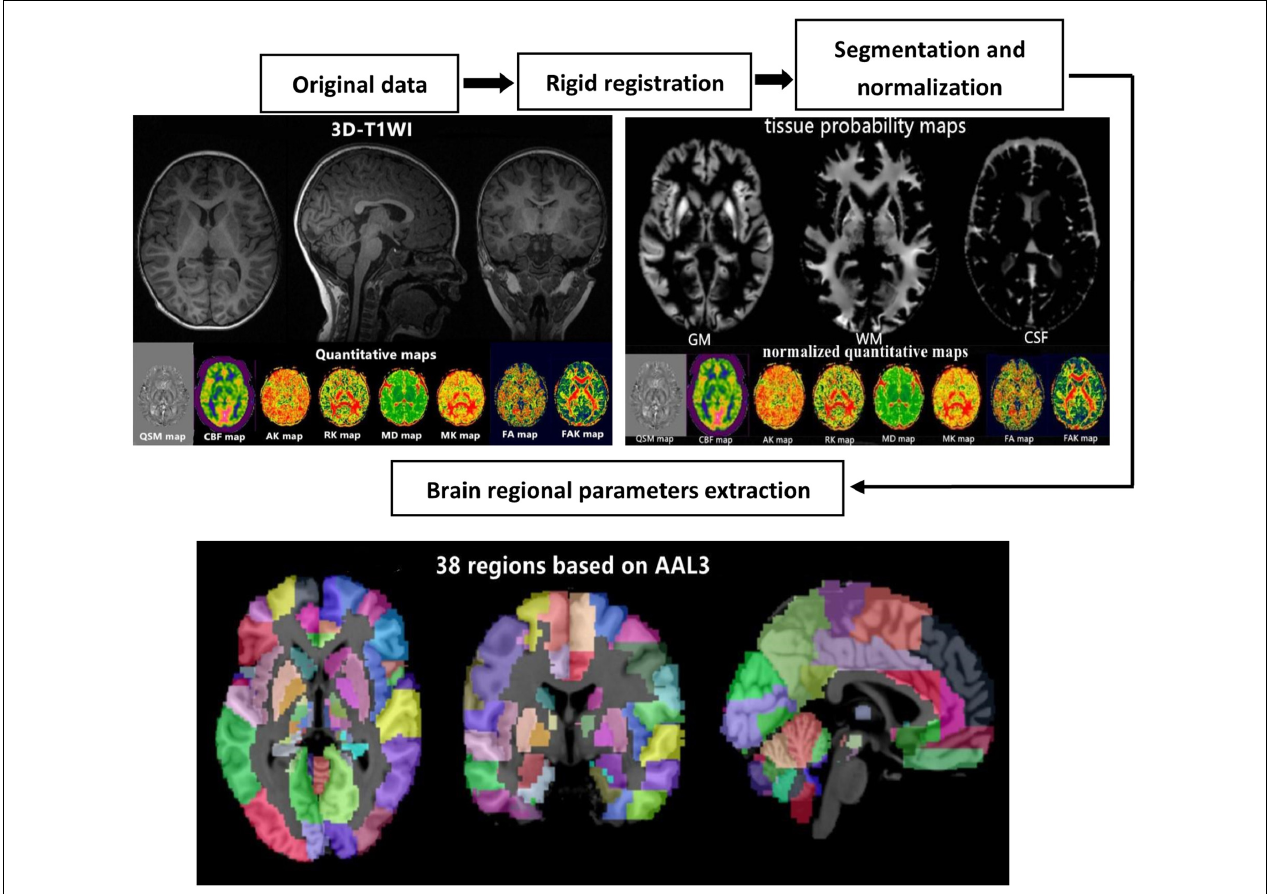
FIGURE 1 | Schematic diagram of the image processing and parameter